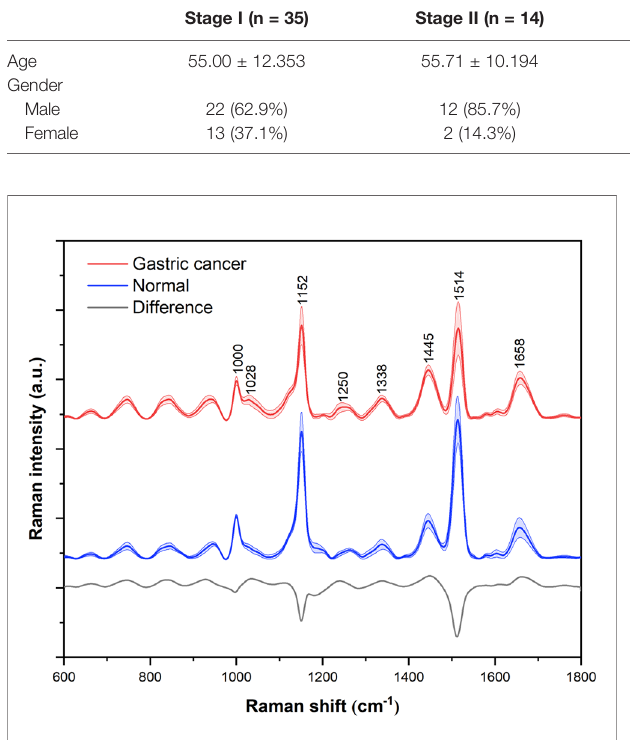
FIGURE 4 | Normalized average Raman spectra of gastric cancer (red) and normal (blue) serum samples. The shaded areas represent the standard deviations. Also shown at the bottom is the difference spectrum of gastric cancer minus normal. For the purpose of clarity, spectra have been offset.